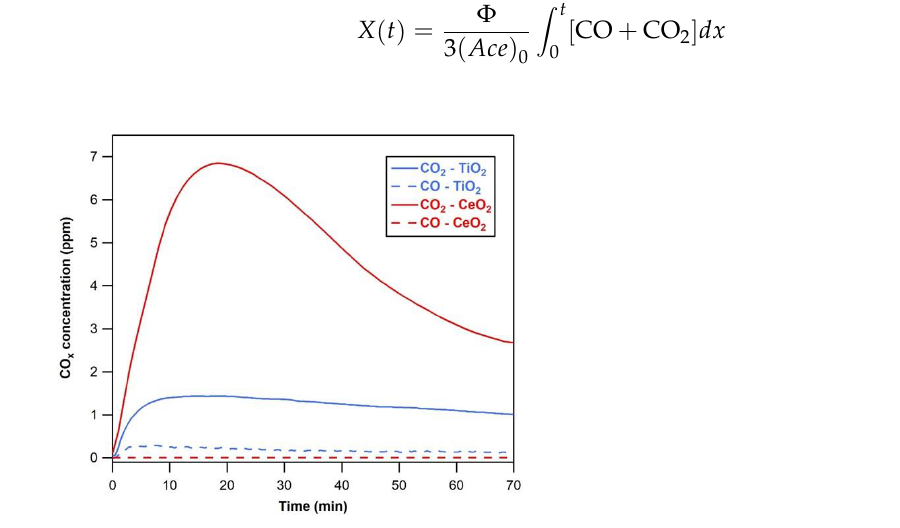
Figure 7. Temporal evolutions of CO and CO 2 at the U-shape reactor outlet during the ozonation of CeO 2 and TiO 2 , preliminarily exposed to acetone (flow rate = 750 mL/min, [O 3 ] 0 = 22 ppm for CeO 2 experiments, [O 3 ] 0 = 24 ppm for TiO 2 ; 100 mg CeO 2 , 200 mg TiO 2 ).